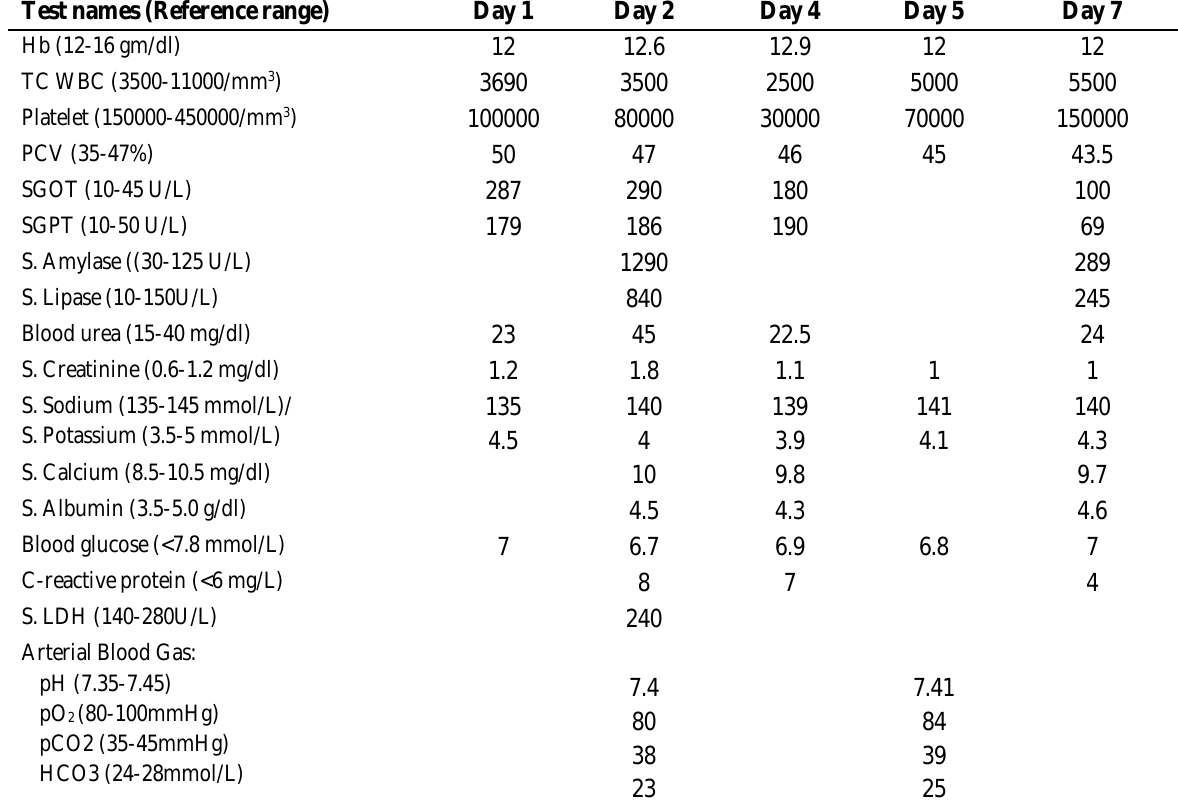
Table 1: Investigations chart